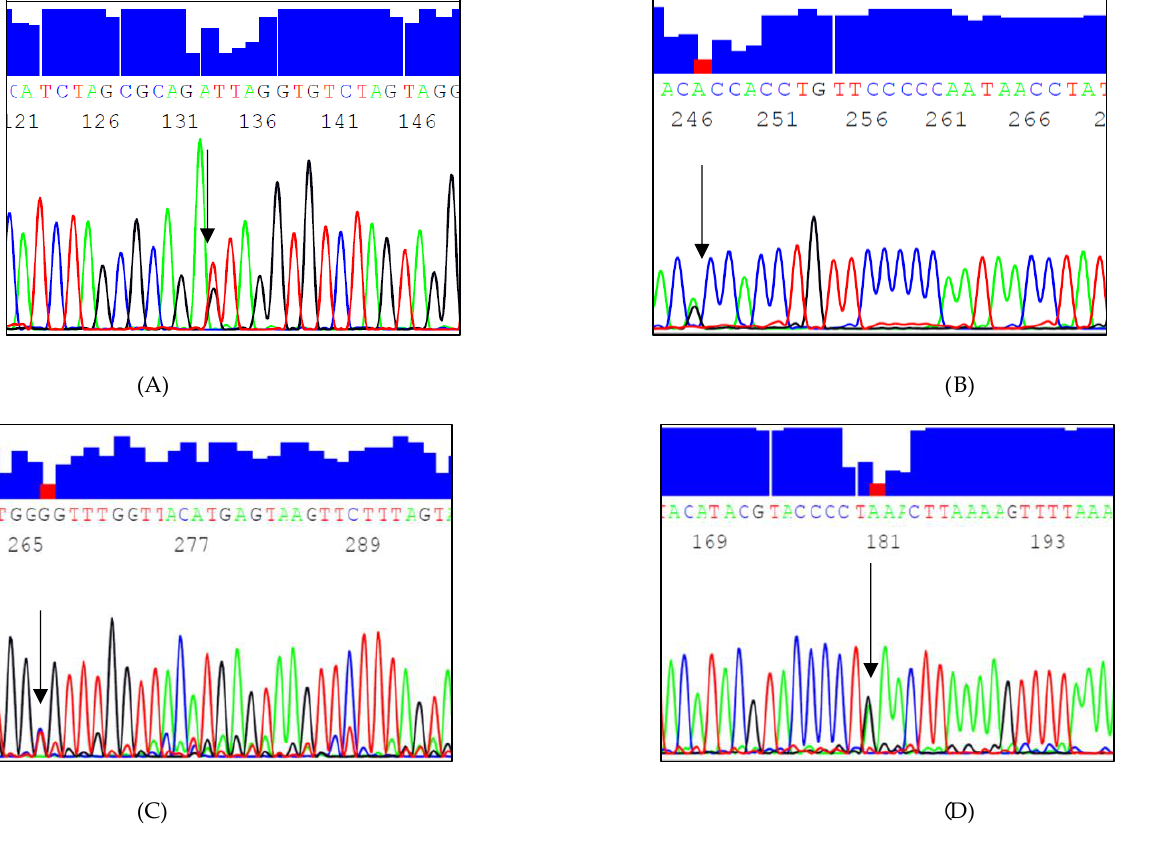
Figure 2. Sequencing electropherograms of the target regions (8:19956194-19956691 and 8:19958317- 19958887) in intron 6 at the LPL gene locus showing known and novel single nucleotide polymor- phisms (SNPs) ( A ) c.1019-533A>C (rs295) (reverse strand: T>G); ( B ) c.1019-646T>C (rs294) (reverse strand: A>G); ( C ) novel c.1019-646T>G, g.19958614T>G (forward strand); ( D ) novel c.1018+397C>T (reverse strand: G>A).